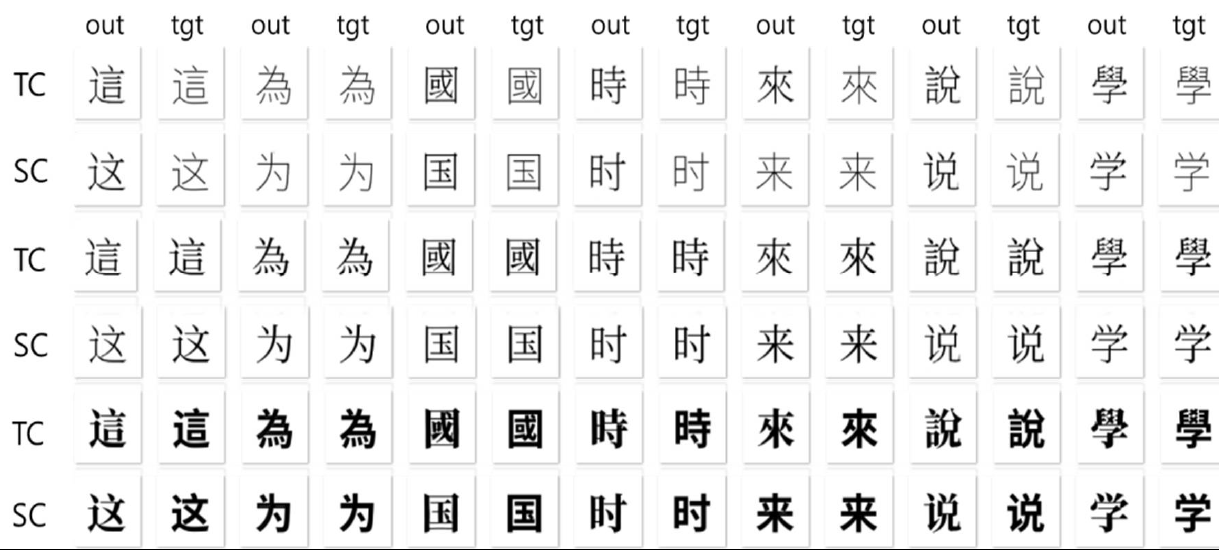
Figure 18. Generated output of TC and SC comparison by the CCFont model.